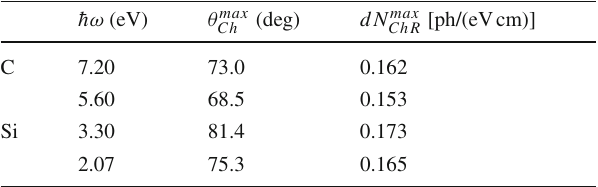
Table 3 Maximum number of ChR-photons hittingthe photon detector of the angular size Δθ = Δϕ = 0 . 3 mrad emitted by μ − and μ + muons in both C and Si crystals at the angles θ max